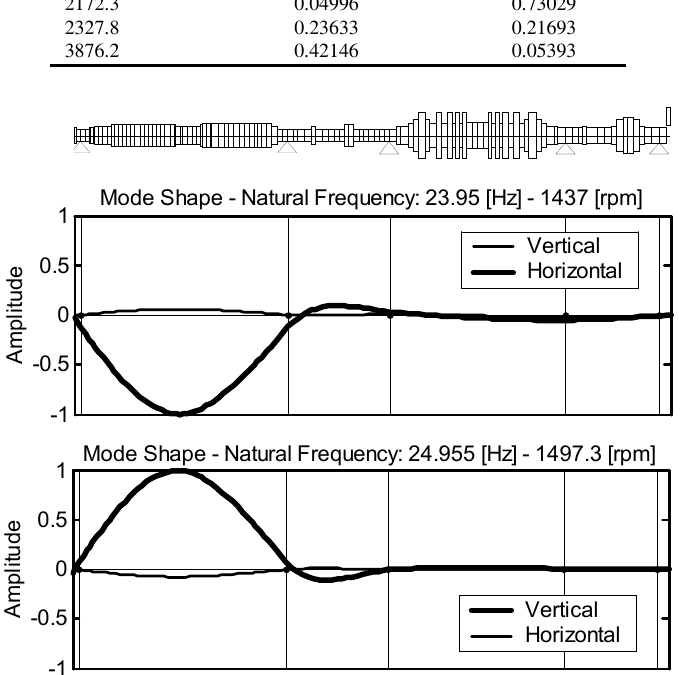
Fig. 17. Normal modes associated with the 2nd and 3rd eigenvalues of the model that correspond to the 1st balance resonance of the HP-IP steam turbine. Seal locations